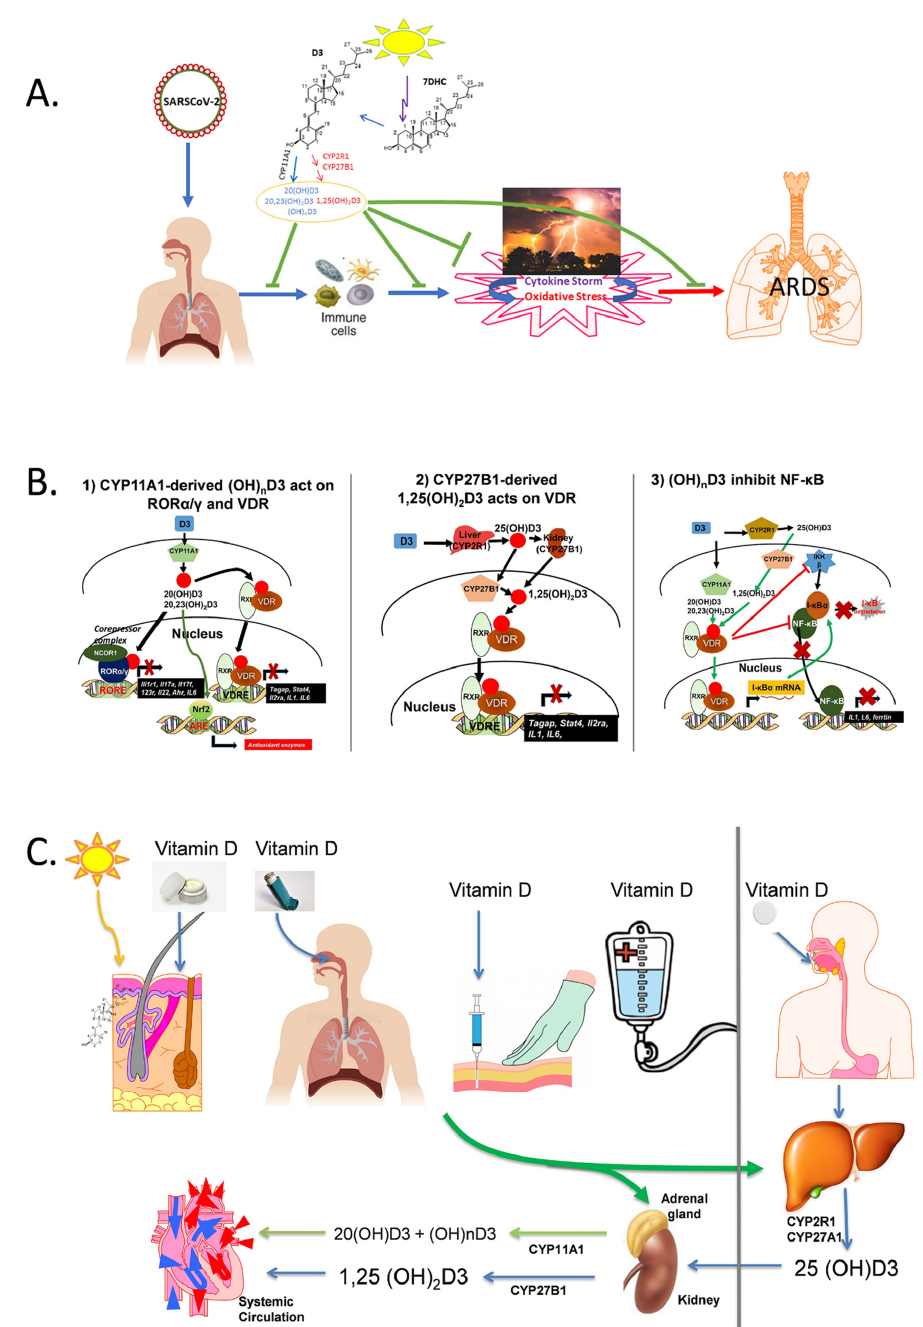
Figure 1. Possible mechanisms by which vitamin D can counteract the COVID-19 illness. In panel ( A ) it is proposed that the novel hydroxyderivatives of vitamin D3, in similar manner as 1,25(OH) 2 D3, inhibit cytokine storm and oxidative stress, with net attenuating effect on ARDS and multiorgan failure induced by COVID-19. Panel ( B ) proposes a mechanism of action of canonical and non- canonical vitamin D-hydroxyderivatives. Vitamin D signaling in mononuclear cells involves the activation of the VDR or inverse agonism on ROR γ with downstream inhibition of inflammatory genes and the suppression of oxidative stress through the activation of NRF2. VDR, vitamin D receptor; RXR, retinoid X receptor; ROR, retinoic acid orphan receptor, RORE, ROR response element; ARE, antioxidant response element; VDRE, vitamin D response element; NRF2, transcription factor NF-E2-related factor 2. Panel ( C ) shows how different routes of vitamin D delivery impact vitamin D hydroxylation/activation patterns. Reprinted with permission from the publisher